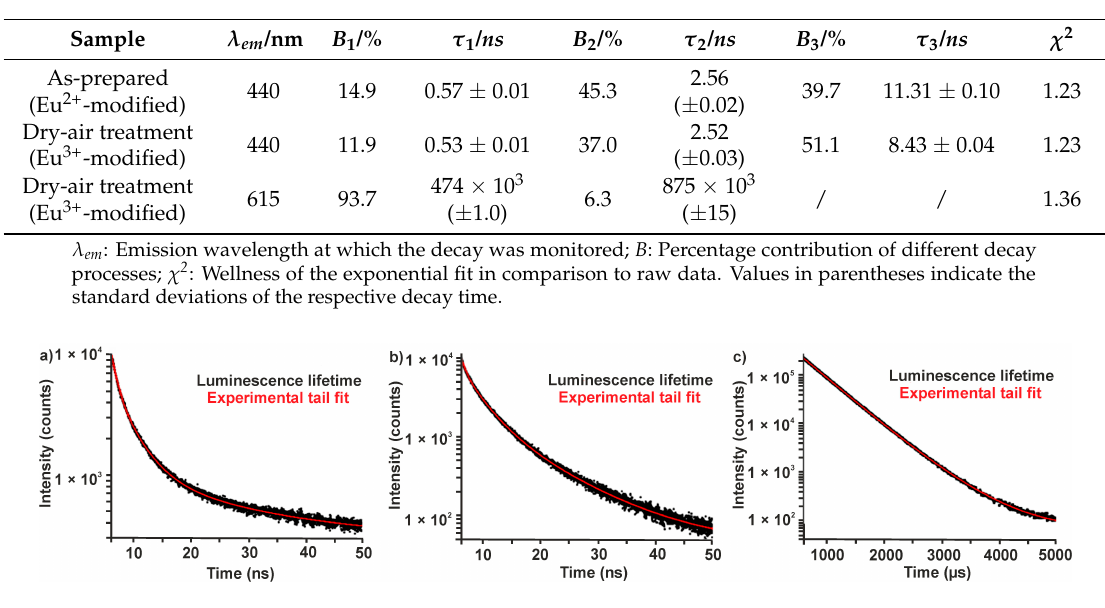
Figure 2. Dry air treatment of conventionally heated Eu-modified C-dots: ( a ) photographs with time-depending emission (UV-LED excitation); ( b ) PL spectra (normalized on C-dot emission at 440 nm); and ( c ) emission intensity of Eu 3+ at 614 nm (all spectra with λ exc = 366 nm). Table 1. Photoluminescence lifetimes of Eu-modified C-dots (suspensions in PEG400, λ exc = 375 nm).